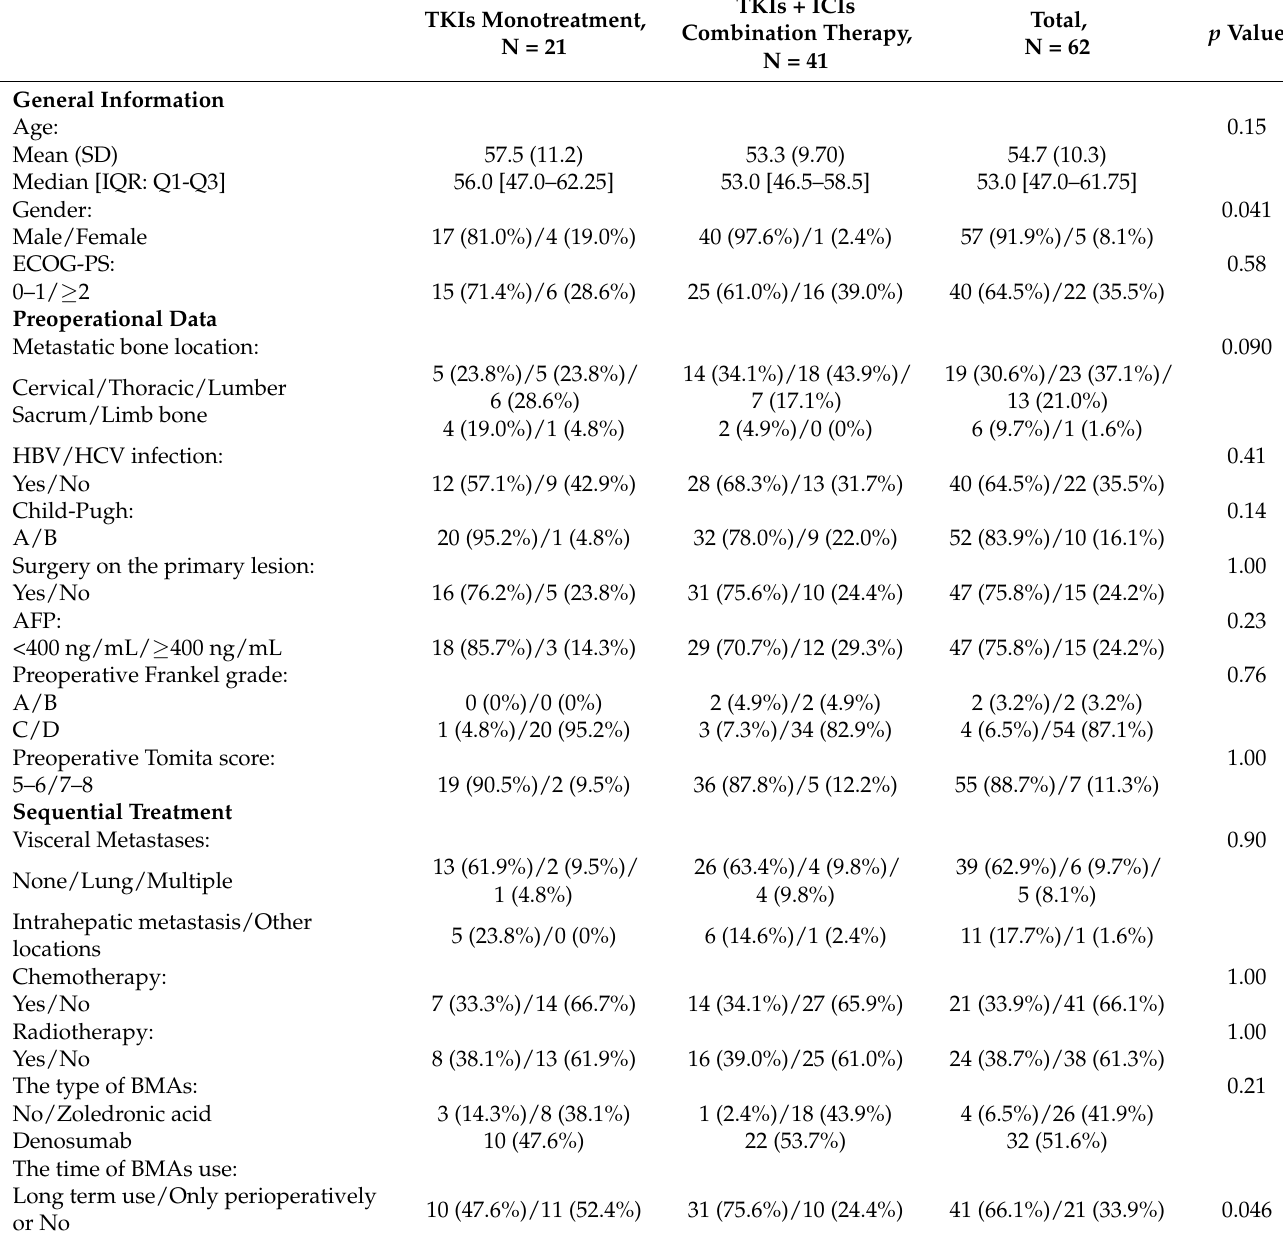
Table 1. Baseline characteristics of patients receiving TKIs monotreatment and TKIs + ICIs combina- tion therapy, N = 62